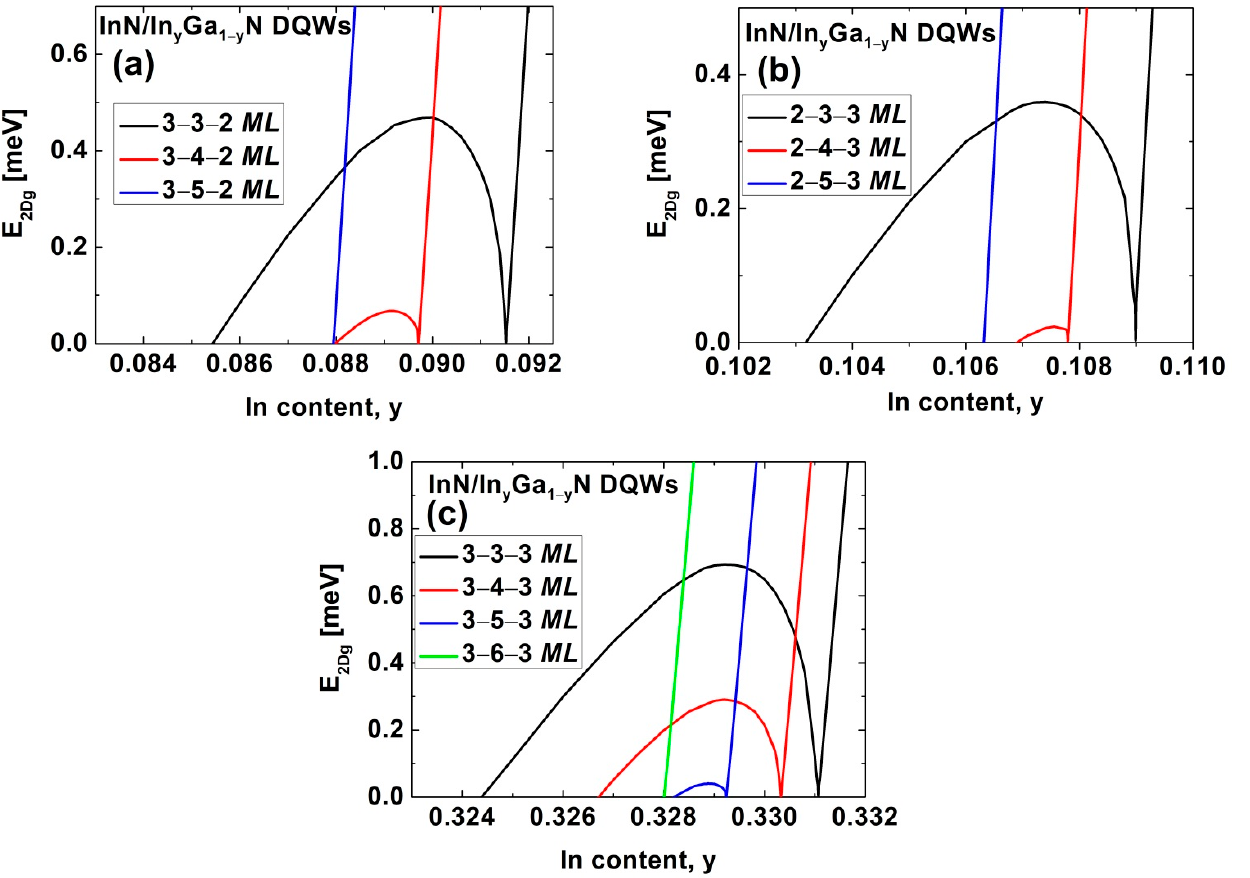
Figure 5. The E 2 Dg as a function of the In content in the barriers for InN/In y Ga 1 − y N DQWs with ( a ) L qw , A = 3 MLs , L qw , B = 2 MLs , and L ib = 3, 4, 5 MLs ; ( b ) L qw , A = 2 MLs , L qw , B = 3 MLs , and L ib = 3, 4, 5 MLs ; and ( c ) L qw , A = 3 MLs , L qw , B = 3 MLs , and L ib = 3, 4, 5,6 MLs . The results obtained for different values of L ib are marked with different